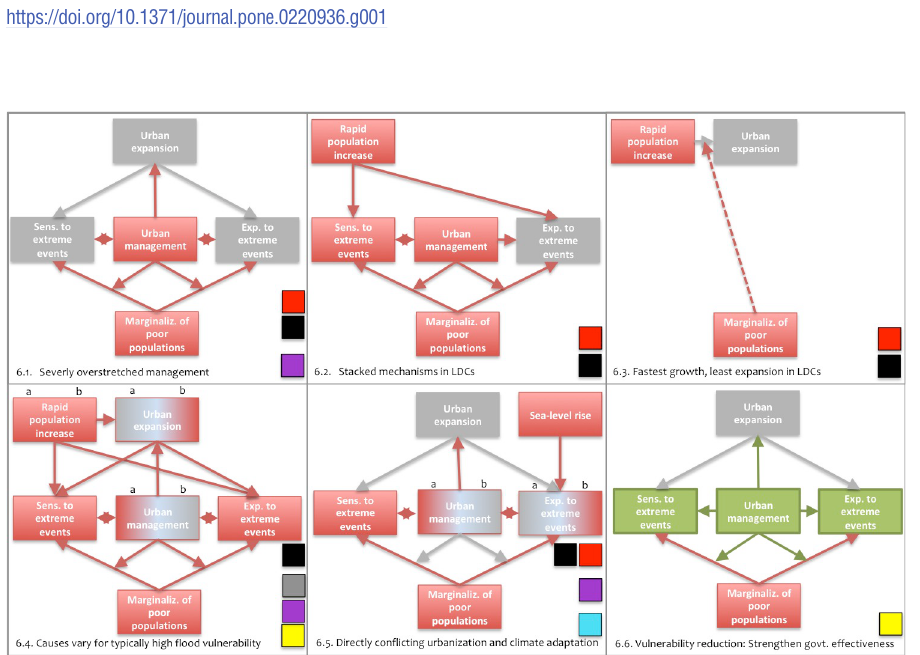
Fig 2. Six typical configurations of socio-ecological vulnerability of urban populations under rapid coastal urbanization. Based on Fig 1 (key determinants of vulnerability and how they influence each other) each diagram is a typical and particularly problematic configuration. Red boxes and arrows signify particularly problematic situations and influences based on indicator values, grey boxes signify less problematic situations and influences. Green boxes and arrows refer to entry points for vulnerability reduction. The number of each diagram refers to a corresponding subsection in the Discussion section. The colored boxes in the lower right hand corners indicate which urban vulnerability profiles each diagram applies to. LDCs stands for Least Developed